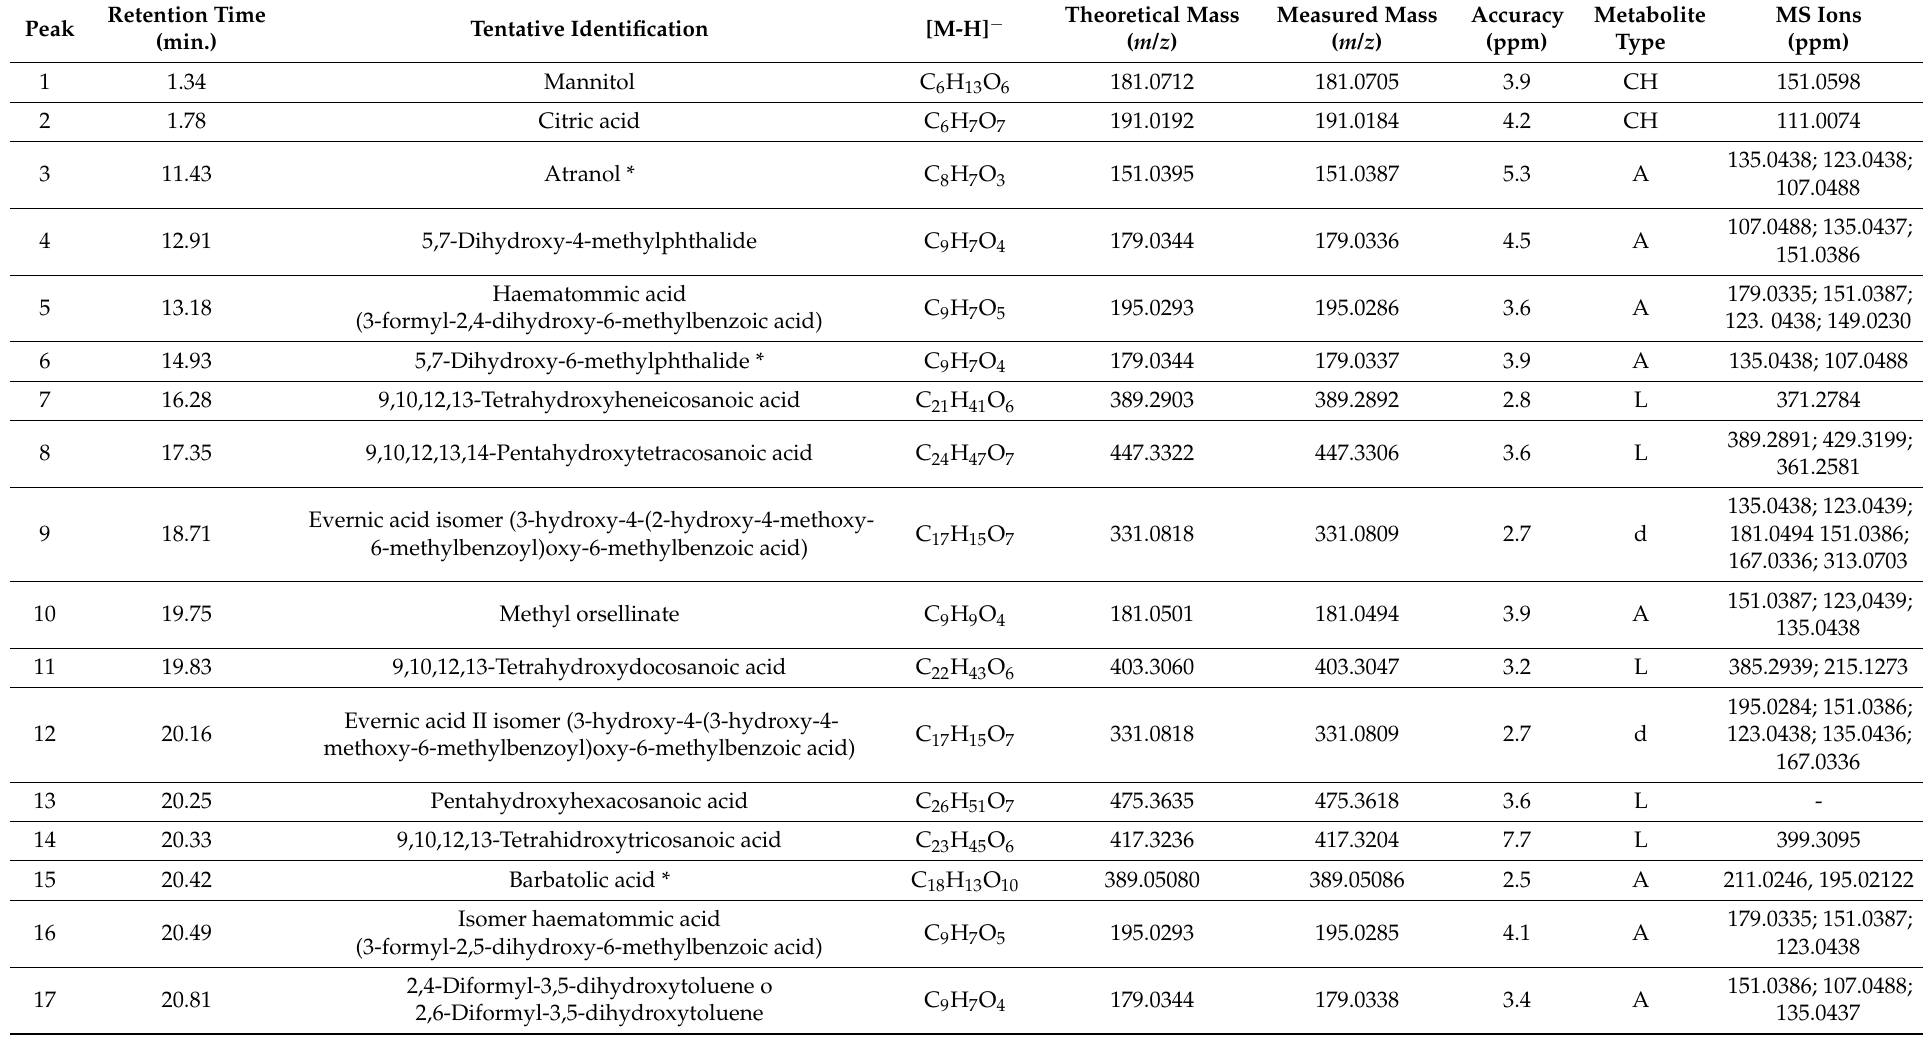
Table 1. Identification of phenolic compounds by HESI orbitrap HR-MS of Himantormia lugubris ethanolic